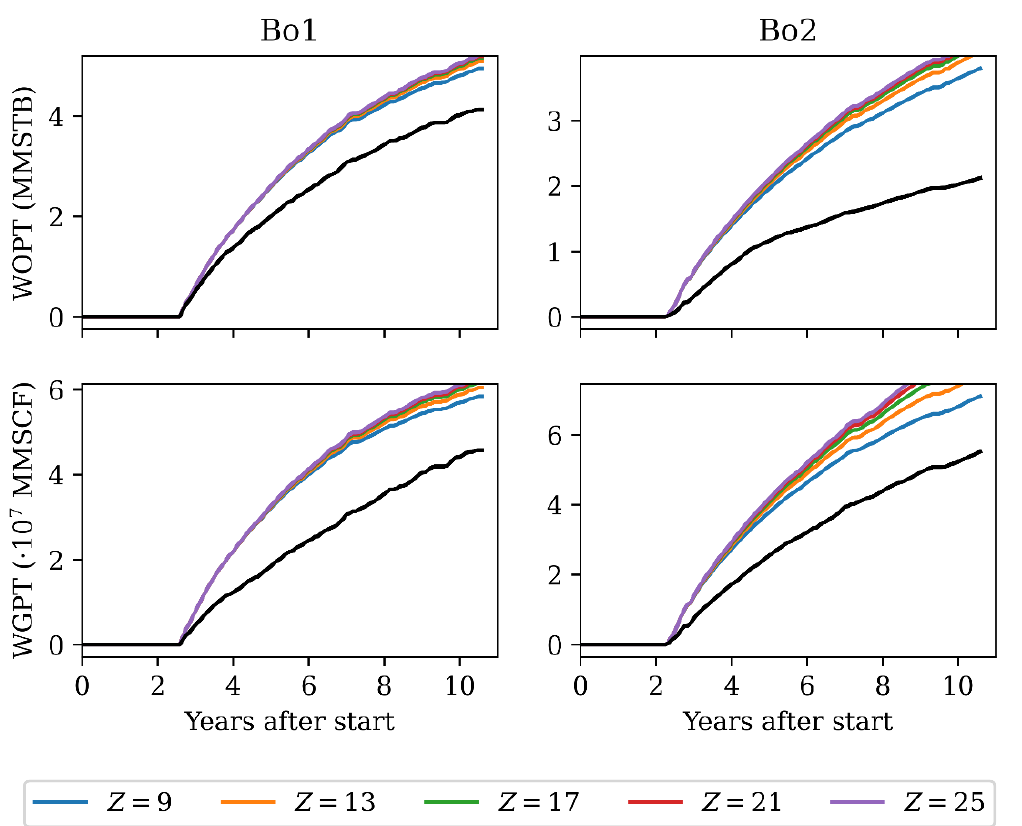
Figure 12. The production volumes for the Bo model, corresponding to the different relative permeabilities in Figure 10. Black lines denote historical data.